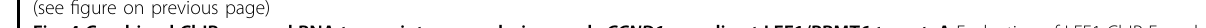
Fig. 4 Combined ChIP-seq and RNA transcriptome analysis reveals CCND1 as a direct LEF1/PRMT6 target. A Evaluation of LEF1 ChIP Encode data in K562 cells and GO-term analysis revealed 65 genes regulating the mitotic cell cycle, which are bound by LEF1. Expression analysis identi fi ed 991 differentially expressed genes upon knockdown of PRMT6 in K562 cells. Of these, four genes are cell cycle associated LEF1 targets, BCL6, BTG2, CCND1, and CDKN2D. The arrows indicate upregulation or downregulation upon PRMT6 knockdown. B mRNA expression analysis of two different shRNA constructs against PRMT6 (shP6). GAPDH expression was used for normalization. C – F The four identi fi ed cell cycle associated LEF1/PRMT6 targets were re-analysed by quantitative real-time PCR 7 days after shPRMT6 transduction. Error bars represent the standard deviation from at least three independent experiments. G Cell cycle analysis was performed fi ve days after PRMT6 knockdown in K562 cells. H Percentage of cells within the G1 phase of the cell cycle increased upon PRMT6 knockdown in K562 cells. I , J ChIP assay shows that LEF1 is bound close to the CCND1 transcriptional start site (TSS). This binding is increased upon LEF1 over expression. The negative control ( − 4000 bp from the TSS) is displayed in J . K ChIP-assay shows that PRMT6 is bound close to the CCND1 transcriptional start site (TSS), but not to the − 4000 region. ChIP were performed with an anti-LEF1 and anti-PRMT6 antibody, respectively. The P-values were calculated using Student ’ s t -test from at least three independent measurements. * P < 0.05; ** P < 0.01; *** P <